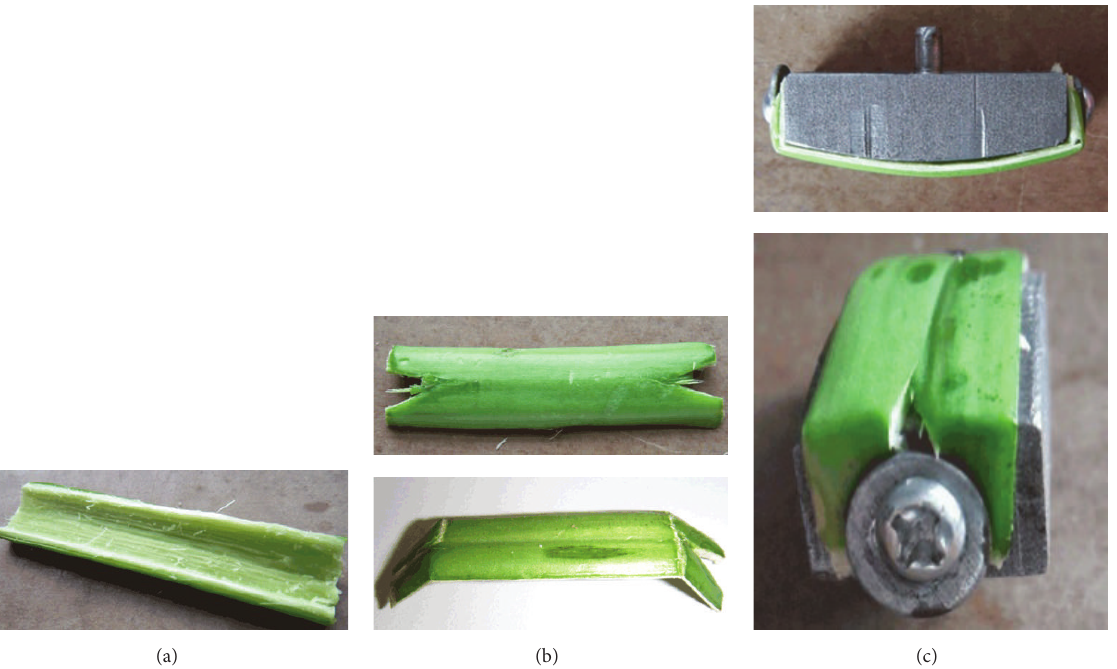
Figure 5: The process of manufacturing and installation of rape stalk sample (upper